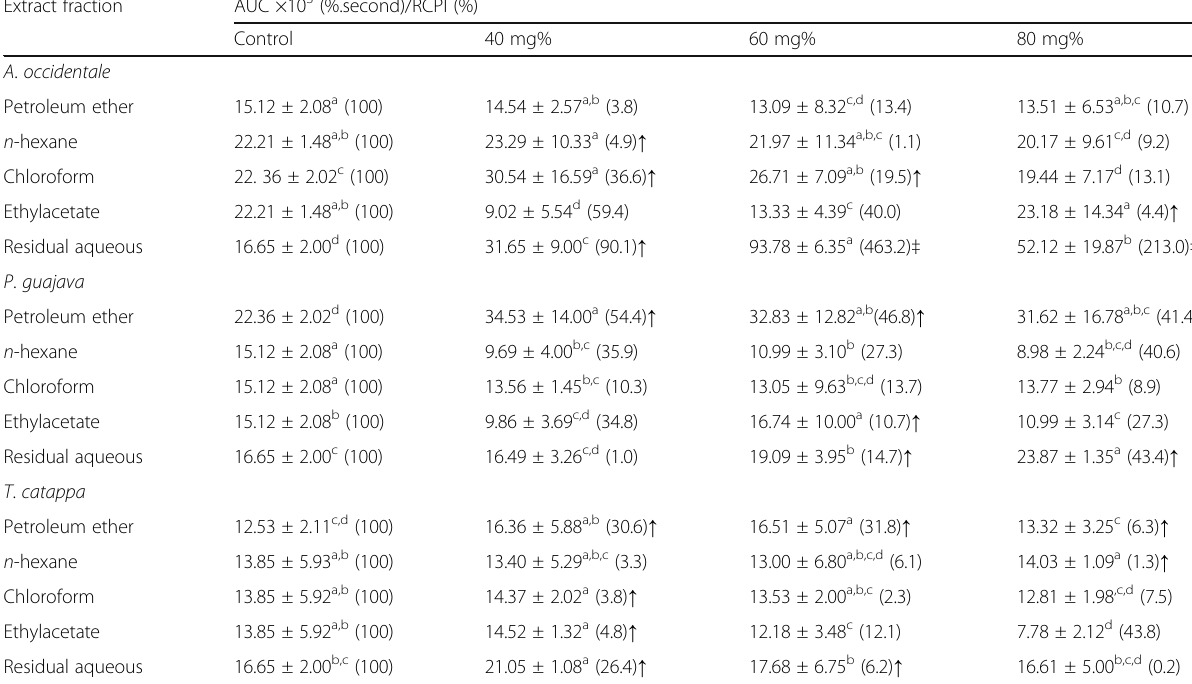
Table 3 Cumulative inhibition/activation of poly-dHbS-M by fractionated leaf extracts of A . occidentale , P . guajava , and T . catappa Extract